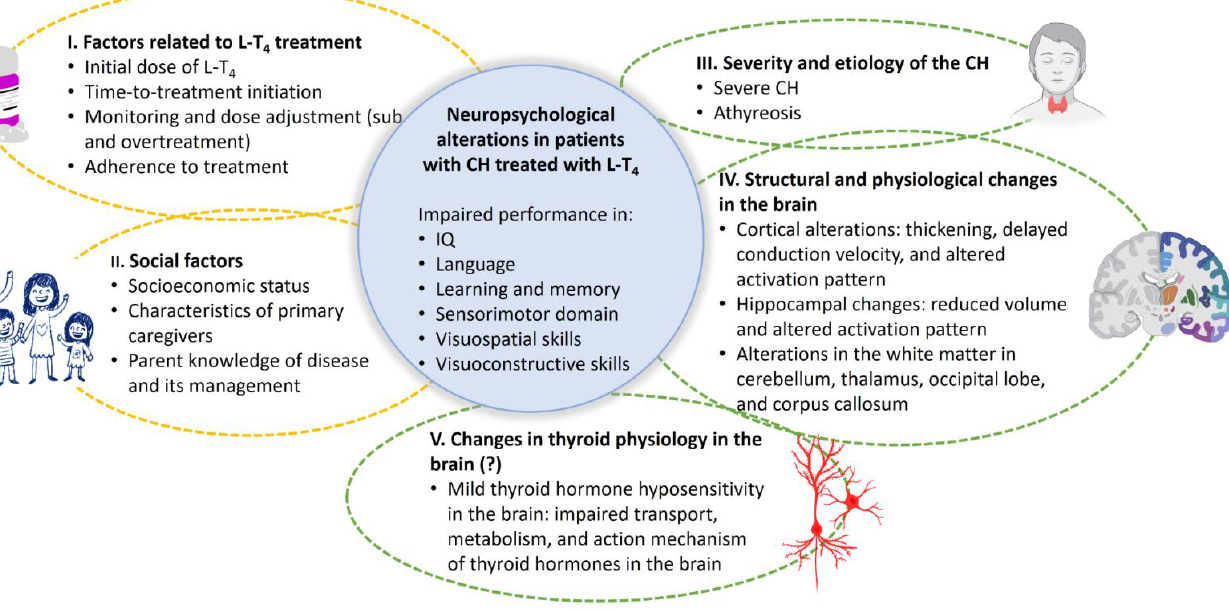
Figure 3. Factors related to the neuropsychological alterations found in patients with congenital hypothyroidism treated with levothyroxine (L-T 4 ). The onset and severity of the neuropsychological alterations in patients with congenital hypothyroidism treated with L-T 4 are related to extrinsic (dotted yellow line) and intrinsic (dotted green line) factors. Extrinsic factors include those related to L-T 4 treatment (I) and social elements (II). Intrinsic factors correspond to severity and etiology of congenital hypothyroidism (III), and changes in the brain, such as structural and physiological alterations in specific brain regions (IV) and modifications in the thyroid physiology of the brain (V). This review proposes the hypothesis that modifications in the brain thyroid physiology lead to a state of mild thyroid hormone hyposensitivity that could also contribute to the onset of the neuropsychological sequelae (V).